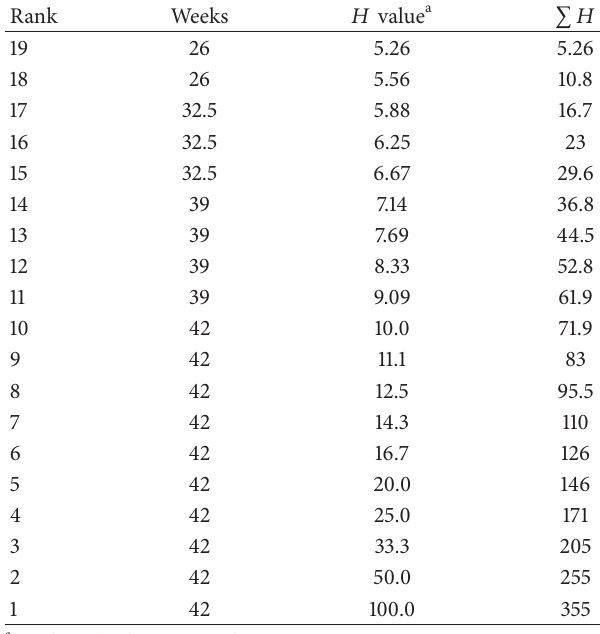
Table 9: Weibull hazard ranking table for dehydrated taro slices stored at 45 ∘ C in PE bags.